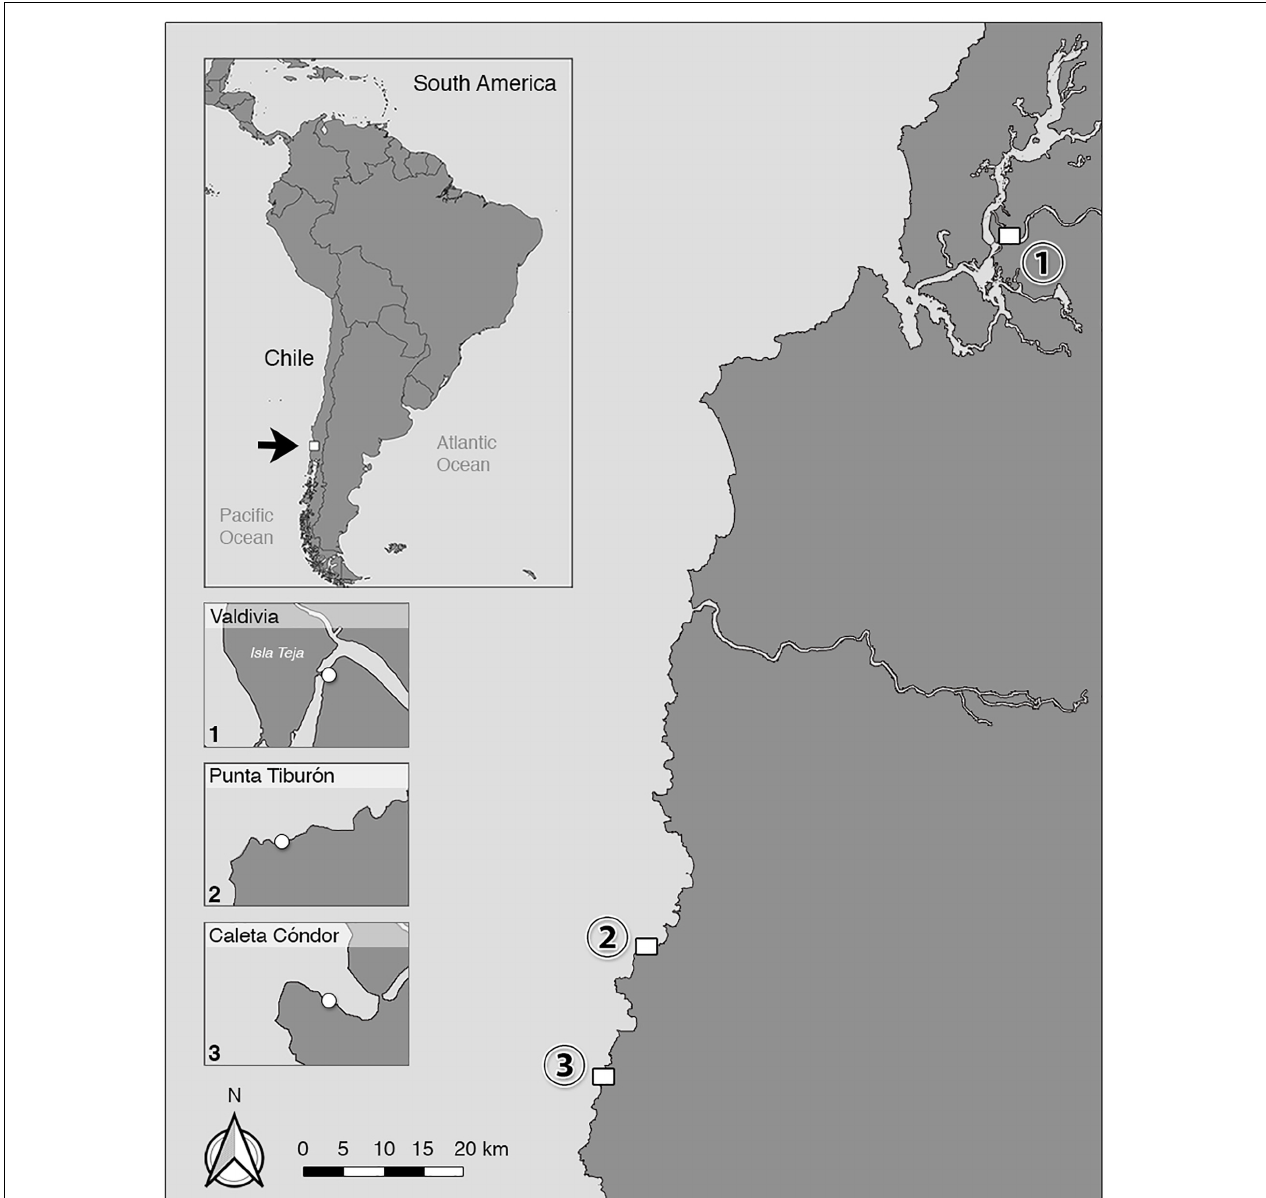
FIGURE 1 | Locations of three different colonies of South American sea lions ( Otaria flavescens ) in Chile probed in this study. Fecal samples were collected from individuals of an “urban” O. flavescens colony in (1) Valdivia (39 ◦ 48 (cid:48) 46.84 (cid:48)(cid:48) S, 73 ◦ 14 (cid:48) 54.212 (cid:48)(cid:48) W; Región de Los Ríos), and from two colonies at the Pacific coast located in (2) Punta Tiburón (40 ◦ 37 (cid:48) 58.073 (cid:48)(cid:48) S, 73 ◦ 47 (cid:48) 43.828 (cid:48)(cid:48) W) and (3) Caleta Cóndor (40 ◦ 46 (cid:48) 23.581 (cid:48)(cid:48) S, 73 ◦ 51 (cid:48) 7.761 (cid:48)(cid:48) W; Región de Los Lagos).